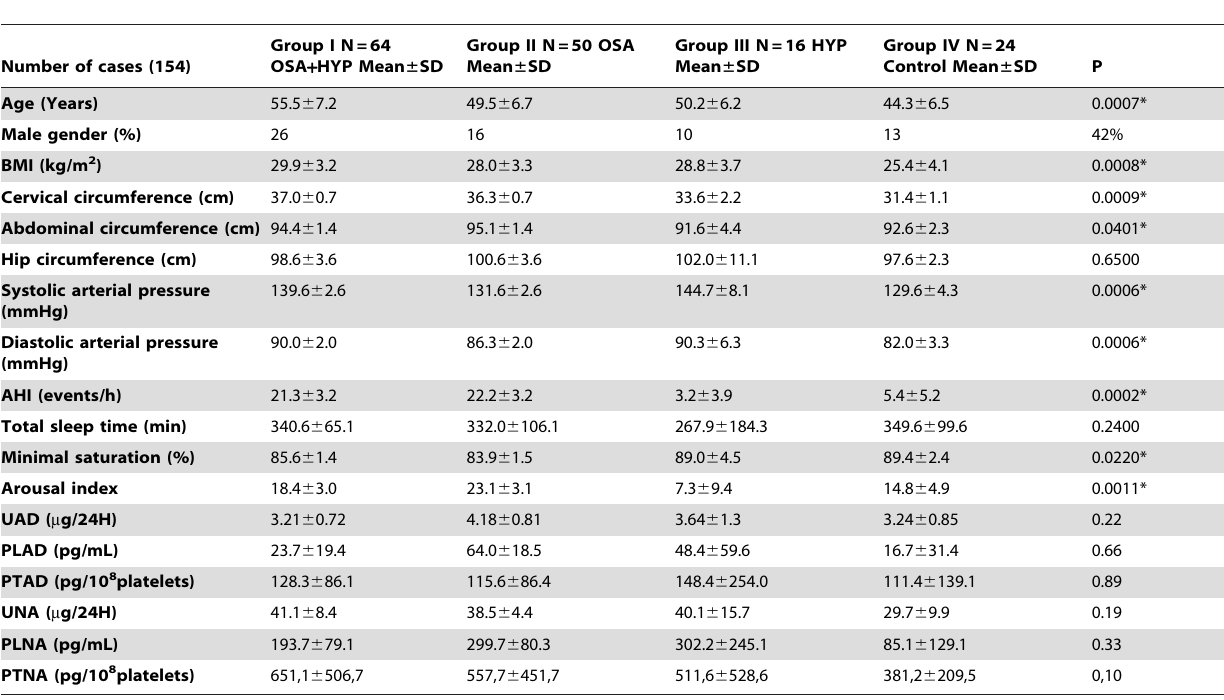
Table 1. Anthropometric, clinical, polysomnographic and catecholamine data, presented as means and standard deviations and corresponding to the baseline characteristics of the